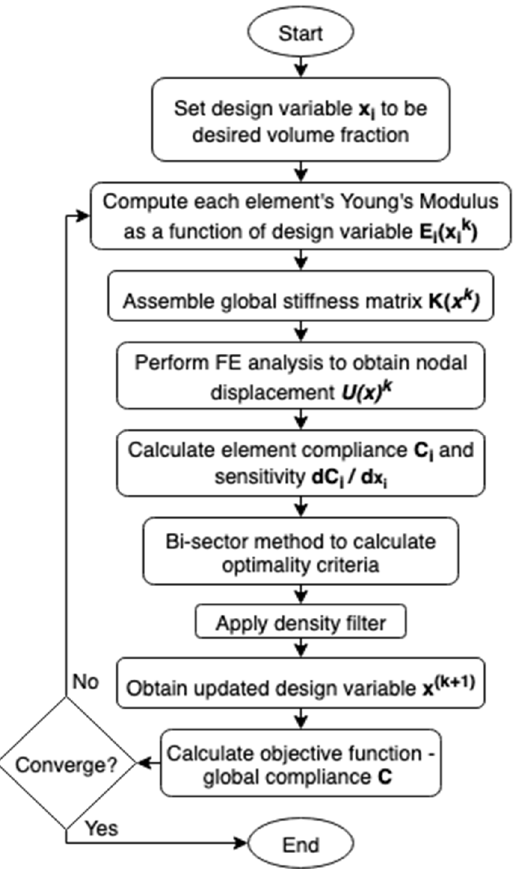
Figure 1. Overview of the Solid Isotropic Material with Penalisation optimisation method.